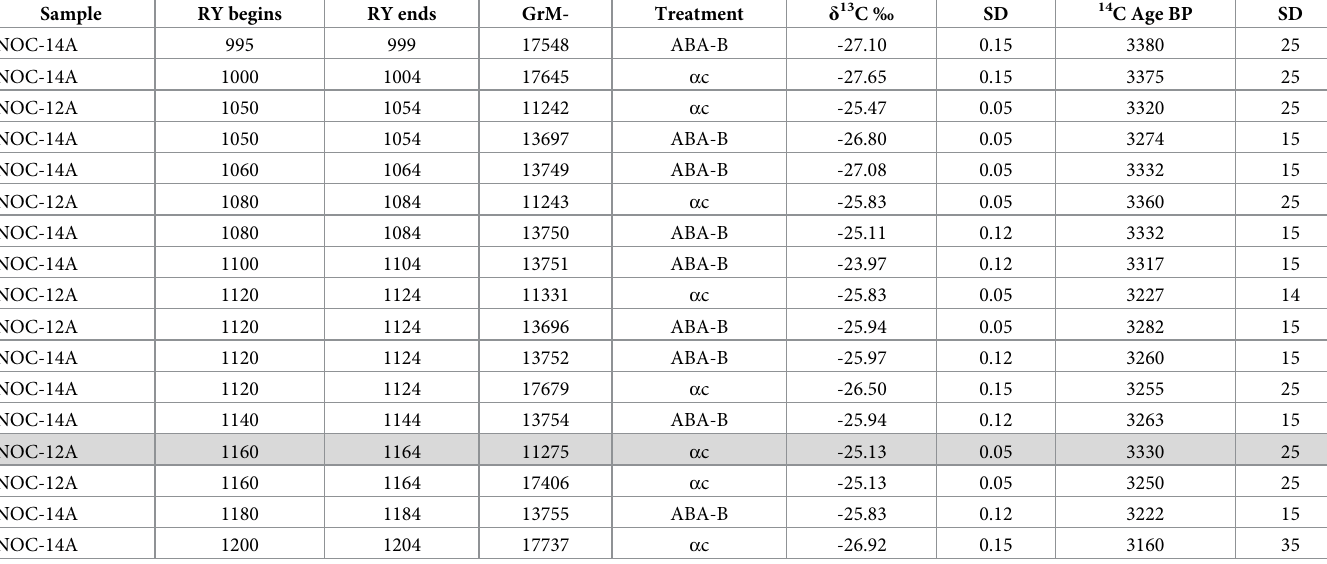
ABA-B = ABA-bleach pretreatment, α c = alpha-cellulose pretreatment (for Groningen methods, see [24]). We note that GrM-11275 is an unexplained outlier (too old) and is not plotted or used. The NOC-12 RY1160-1164 sample (not NOC-14, correcting typo in [25] at S1 Table) was subsequently re-prepared and re-dated as GrM- 17406. We employ this date instead.